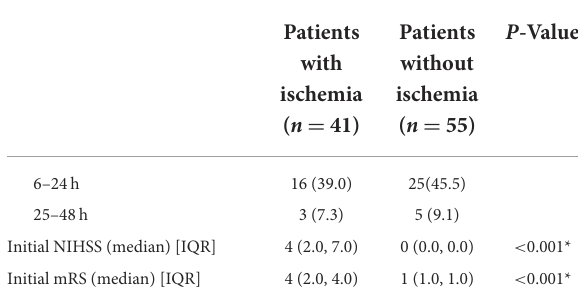
TABLE 1 Baseline characteristics of patients with EVAD-related ischemia and patients without